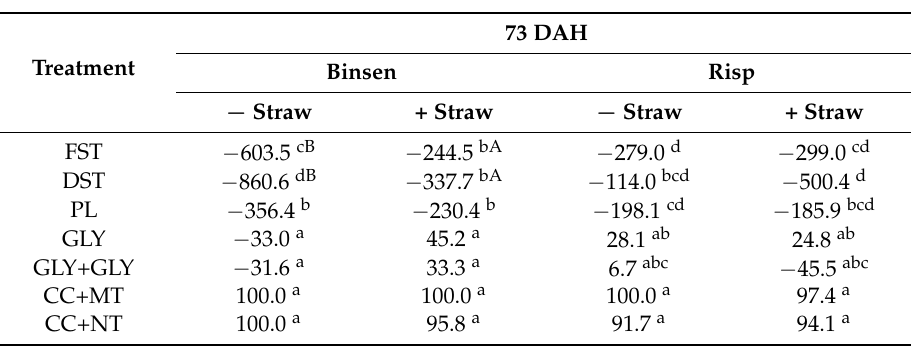
Table 3. Average Alopecurus myosuroides Huds. control efficacy of flat soil tillage (FST), deep soil tillage (DST), ploughing (PL), single glyphosate application (GLY), dual glyphosate application (GLY+GLY), cover crop mixture + mulch-till (CC+MT) and cover crop mixture + no-till (CC+NT) treatments in combination with the presence (+) or absence ( − ) of straw 73 days after harvest (DAH) at the two trials at the fields Binsen and Risp. Different small letters within one column show significant differences according to Tukey–HSD test ( p ≤ 0.05). Means with identical letters do not differ significantly. Different capital letters show significant differences within one experiment and within one treatment according to the presence or absence of straw. Means with no capital letter do not differ according to the Tukey–HSD test ( p ≤